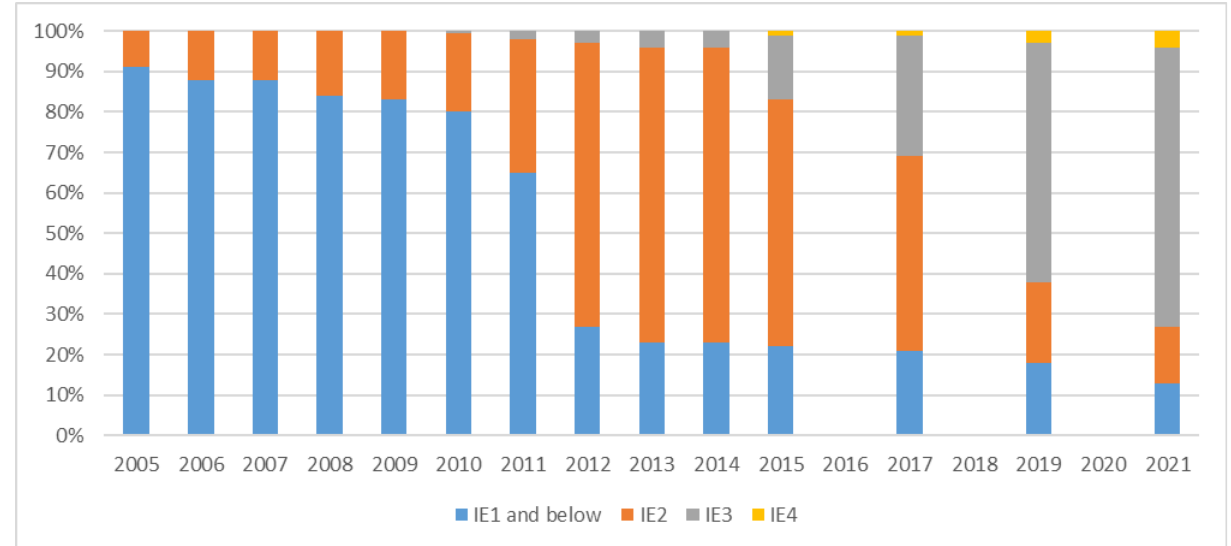
Figure 10. EU motor sales by efficiency class (CEMEP data), 2021.